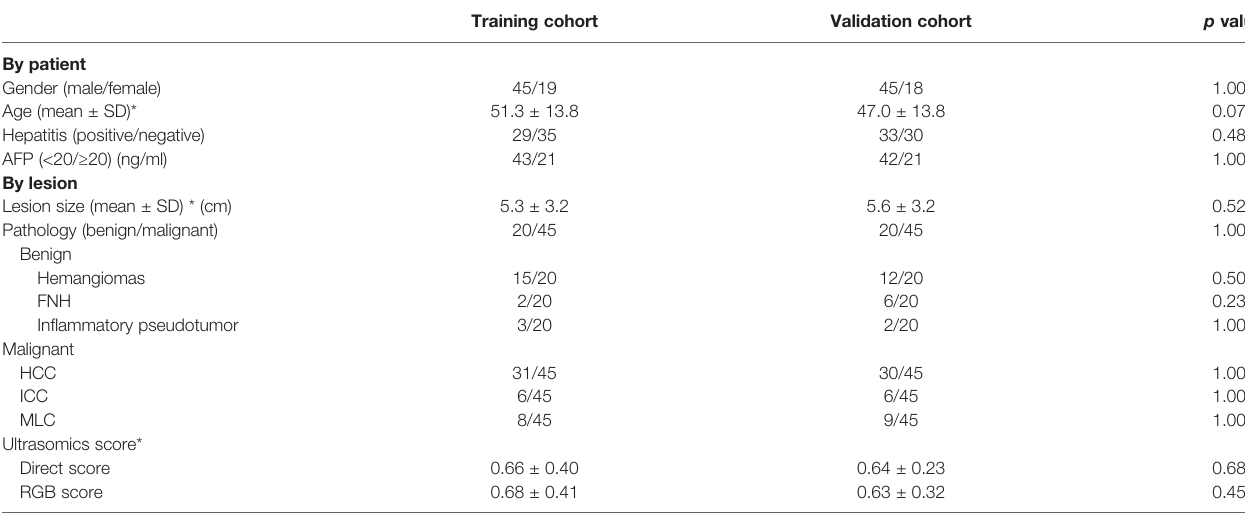
TABLE 1 | Clinical – pathological characteristics and ultrasomics score in the training and validation